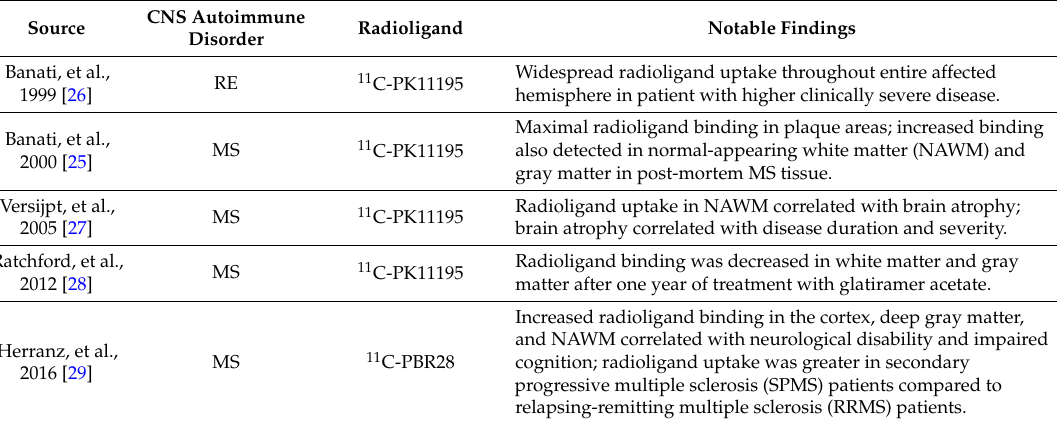
Table 1. Summary of translocator protein-positron emission tomography (TSPO-PET) studies in CNS autoimmune disorders. RE: Rasmussen’s encephalitis; MS: Multiple Sclerosis.